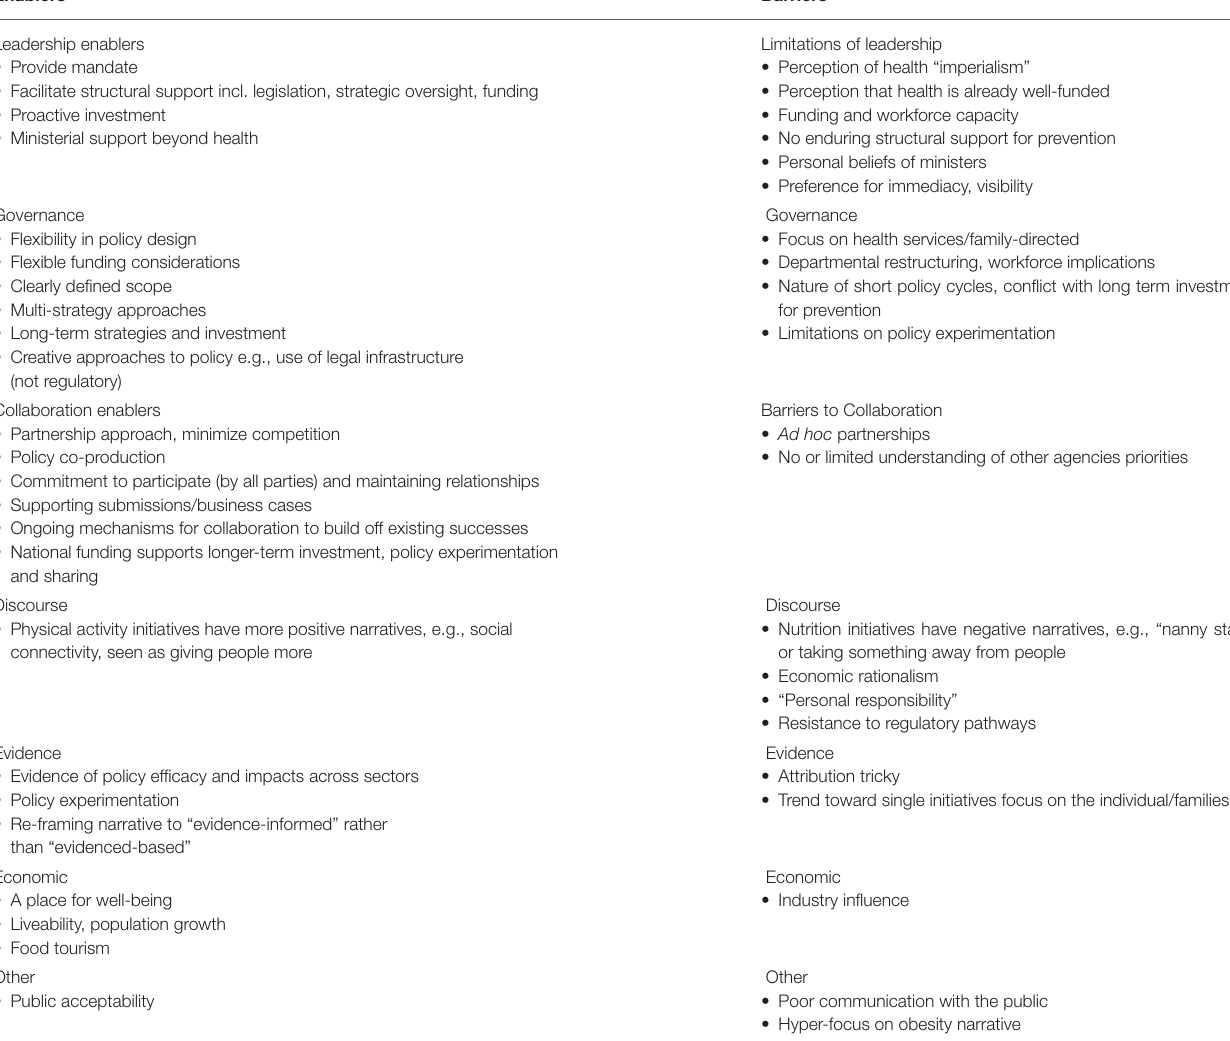
TABLE 3 | Summary of themes—barriers and enablers.